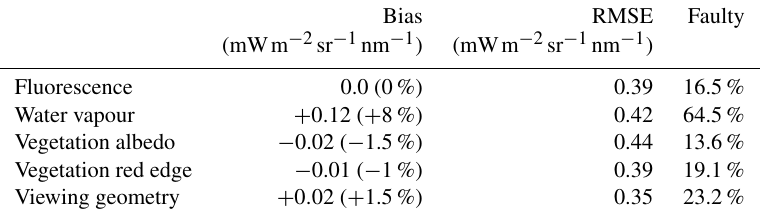
Table 3. Overview of the five experiments (mean of 1000 spectra) to reproduce fluorescence for the narrow fitting window (734–758nm) and eight PCs. Bias is the mean of the differences between assumed and retrieved fluorescence strength (on average 1.5mWm − 2 sr − 1 nm − 1 ), and the RMSE stands for the root of the mean of the squared deviations. Faulty retrievals were not included in the calculation of the bias or the RMSE. “Faulty” retrievals are characterised by high spectral autocorrelation ( > 0 . 2) in their fit residuals. Bias RMSE Faulty (mWm − 2 sr − 1 nm − 1 ) (mWm − 2 sr − 1 nm − 1 ) Fluorescence 0.0 (0%) 0.39 16.5% Water vapour + 0 . 12 ( + 8%) 0.42 64.5% Vegetation albedo − 0.02 ( −